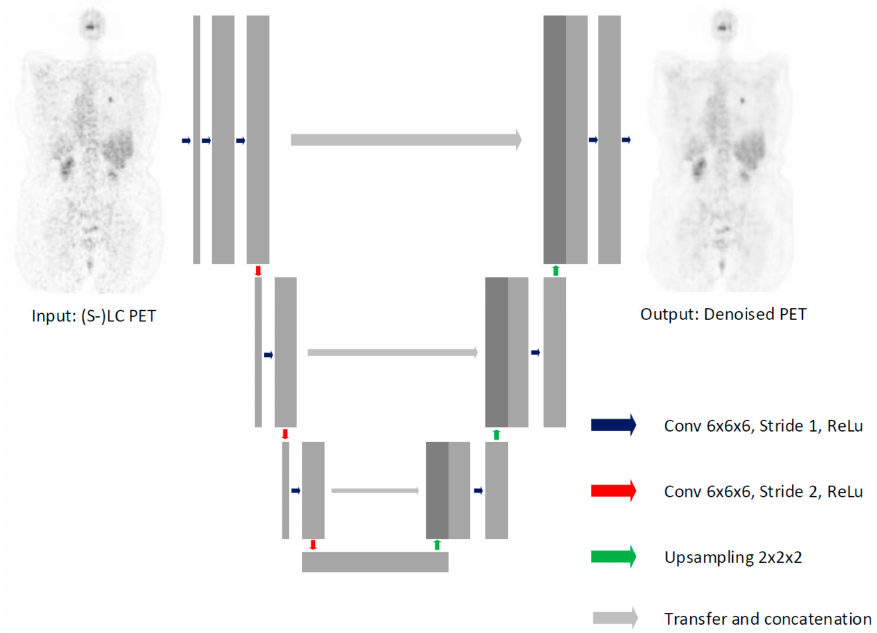
Figure 1. Architecture of the U-net shaped 3D-CNN used in the study. It consists of an encoding and decoding path, which are connected with concatenation layers at each resolution